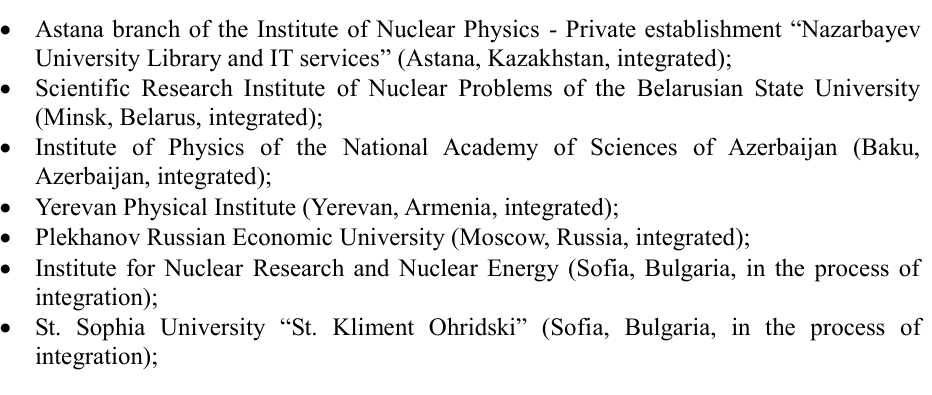
Fig.3 . Map with the distributed cloud infrastructure